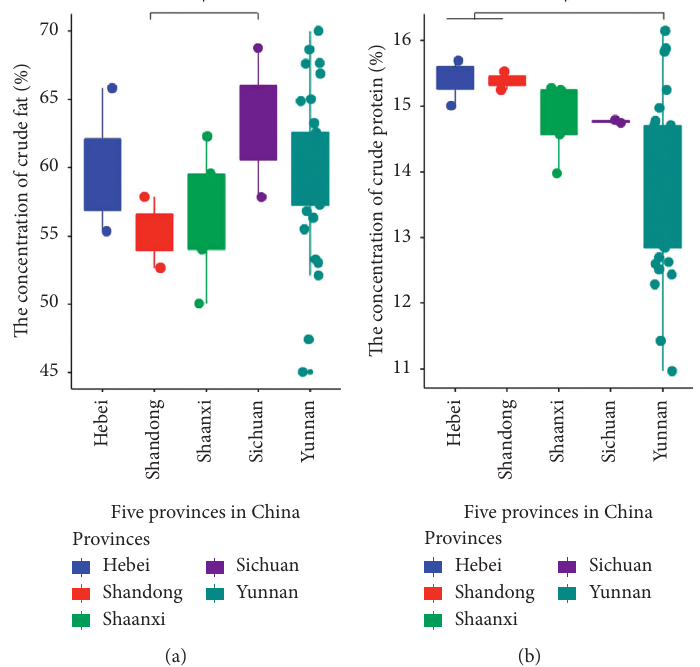
Figure 4: . The (a) crude fat and (b) crude protein in 45 different types of walnut kernels from the main five walnut-planting provinces in China. Dunnett’s multiple-comparison tests were implemented for statistical analysis. Raw p value was labeled, ∗ p < 0 . 1 and ∗∗ p < 0 .